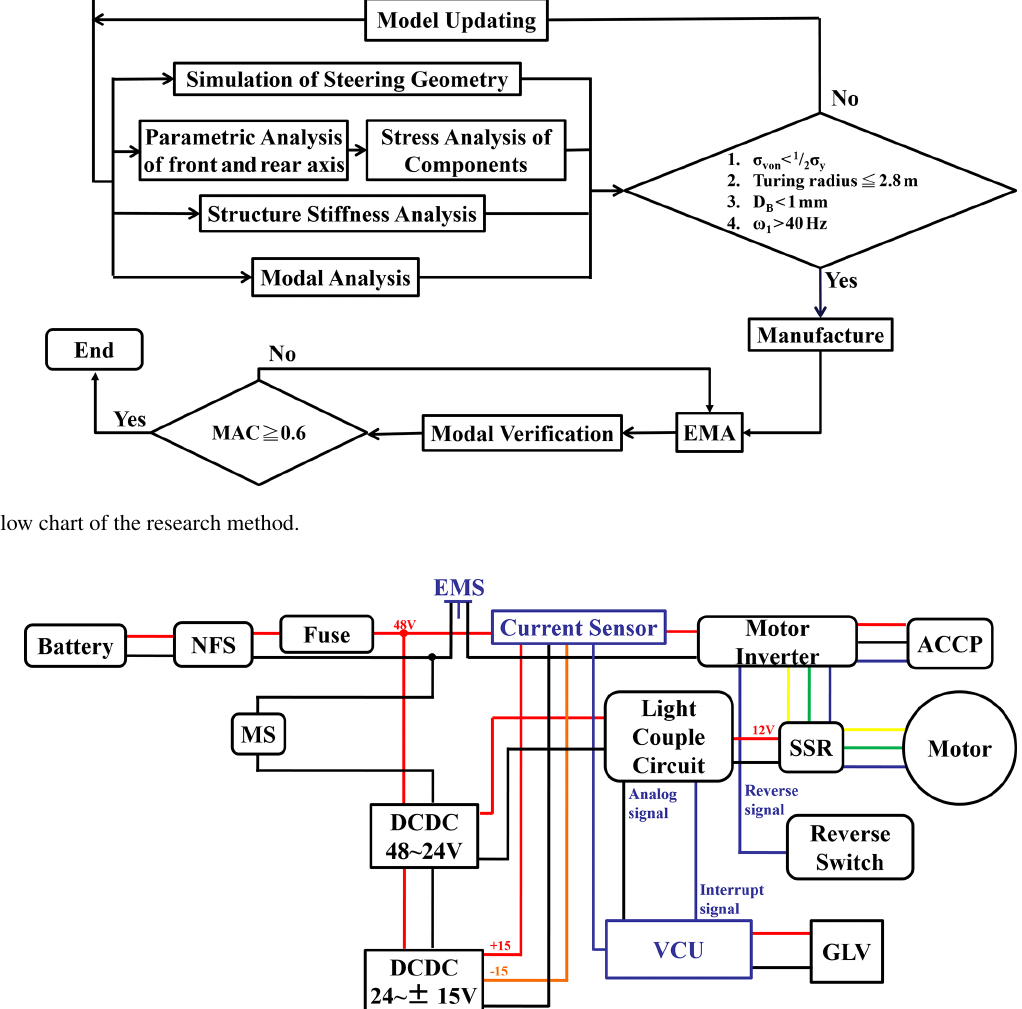
Figure 2. Electrical frame of the power